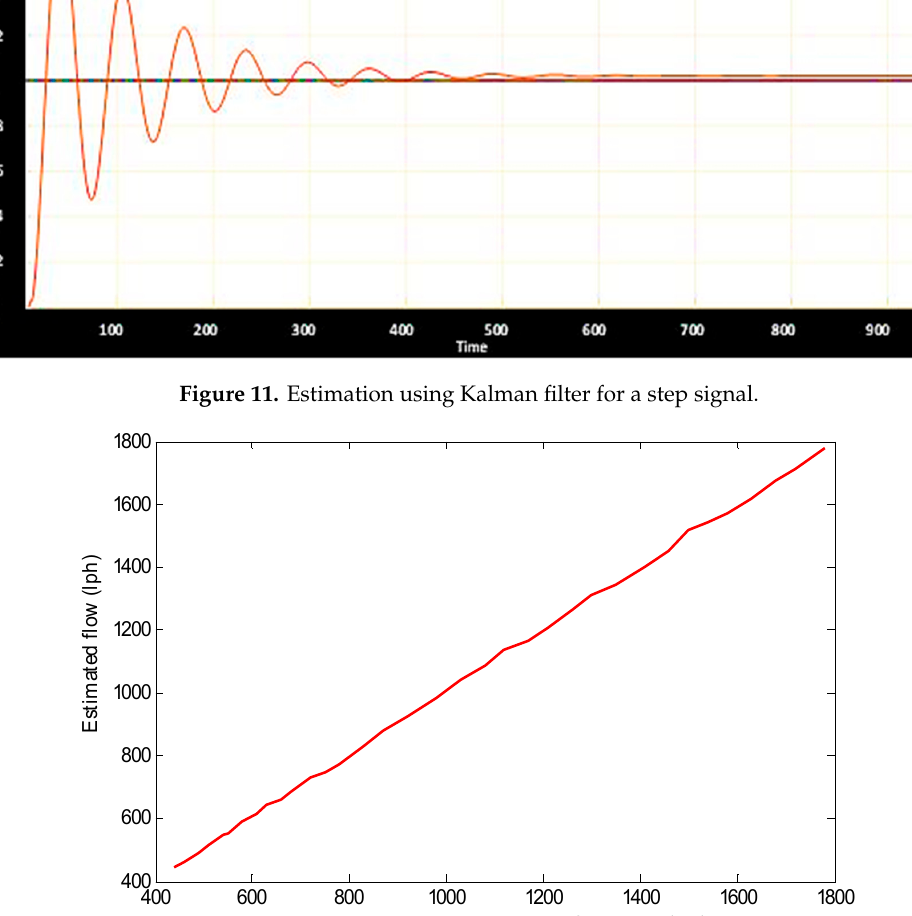
Figure 12. Input-output characteristics of the proposed technique. In order to check the working of the proposed method in closed loop, a PI controller with a proportional gain of 5 and integral gain of 4 was designed for the system. The response of the 400